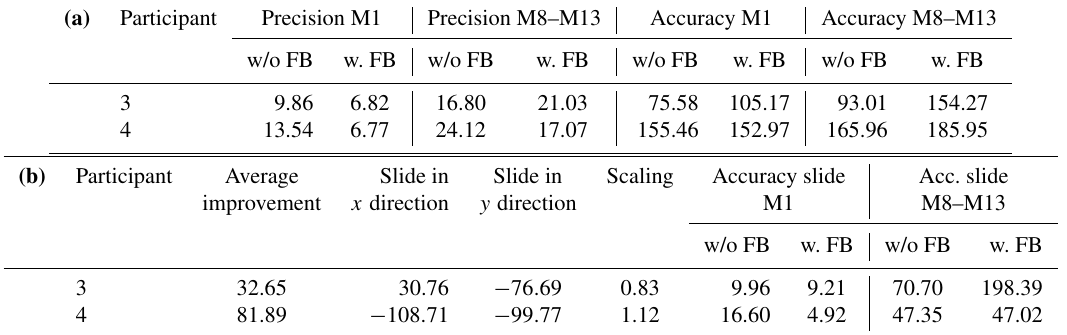
Table 1. M1 describes the centred marker and M8–M13 the outer markers (see Fig. 1). All data are given in millimetres except the scaling factor, which has no units and for which average improvement is shown as a percentage. (a) Accuracy and precision calculated with the steady map and without correction factors. The means of precision and accuracy are stated for the conditions with (w. FB) and without vibrotactile feedback (w/o FB). (b) Effects of the sliding window and scaling are shown by an average improvement rate for each participant, improving the error between 32% and 81%.